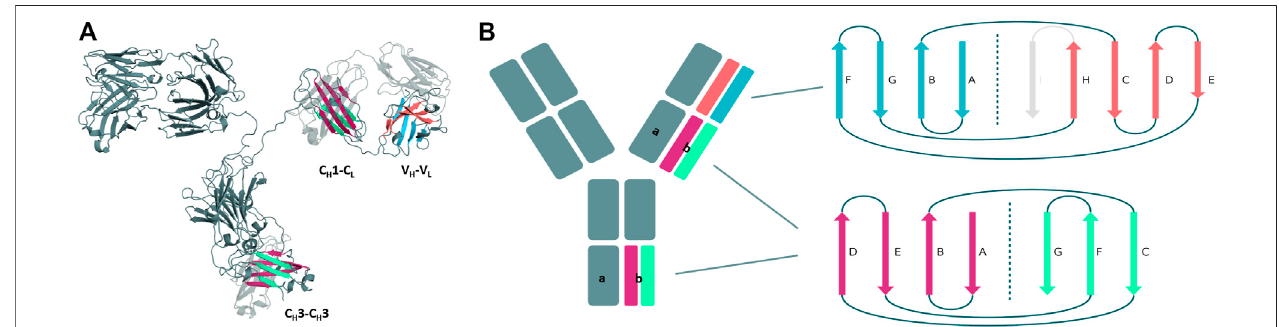
FIGURE 1 | Structural and schematic representation of the modular anatomy of an antibody focusing on the discrete protein domains, which are characterized by the immunoglobulin fold. (A) Crystal structure of a whole IgG2 antibody (PDB: 1IGT) highlighting the different interface classes and their respective domain architecture. (B) Schematic depiction of the tertiary structure features, i.e., number and organization of the β -strands, for each of the individual antibody domains sharing the immunoglobulin fold. The C H 3 and C L /C H 1 domains do not only share a similar structure and topology but also contain the same number and arrangement of β -strands. The variable domains on the other hand differ in their number of β -strands and their architecture and are therefore color-coded